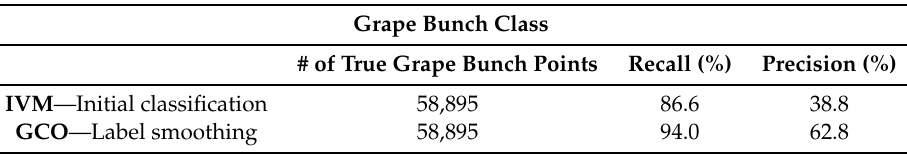
Table 1. Grape bunch class recall and precision for the classification of the VSP trellis grapevine row. IVM, import vector machines.